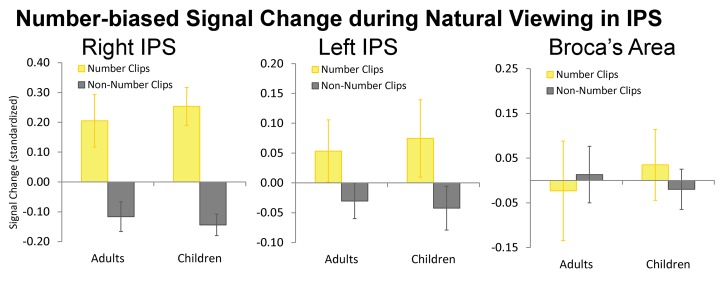
Percent signal change for the numerical content versus the non-numerical content of the natural viewing video in adults and children.Percent signal change in the right IPS is significantly higher for the numerical content than the non-numerical content. The left IPS shows a marginally non-significant trend toward higher activation during numerical content than non-numerical content. Broca's area shows no difference between the numerical and non-numerical content.